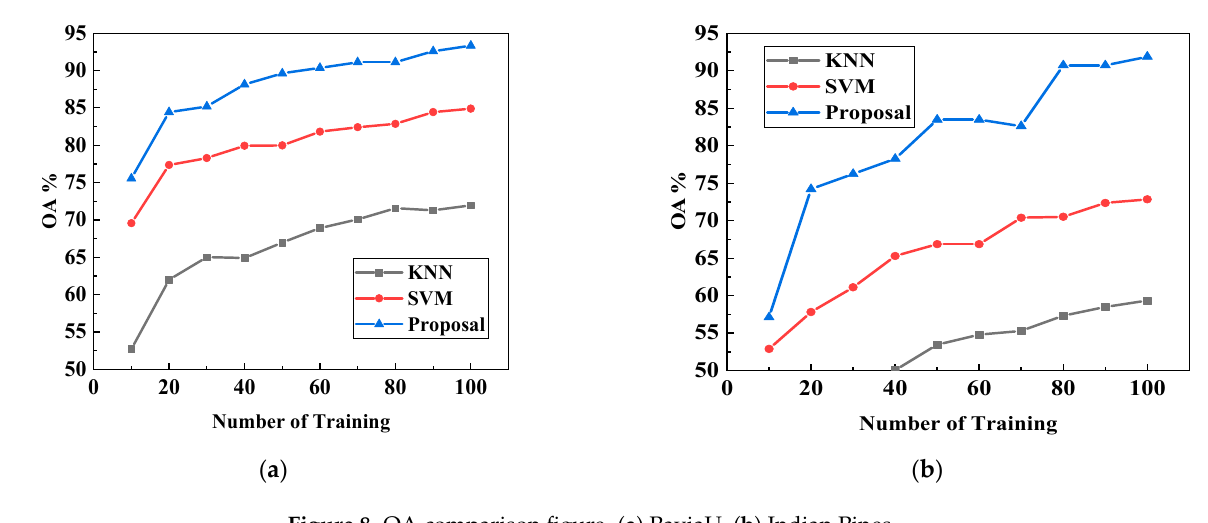
Figure 8. OA comparison figure. ( a ) PaviaU. ( b ) Indian Pines. Table 2. Overall classification accuracy and Kappa coefficient of classification algorithms under different sample numbers with the PaviaU dataset ( K = 1000).